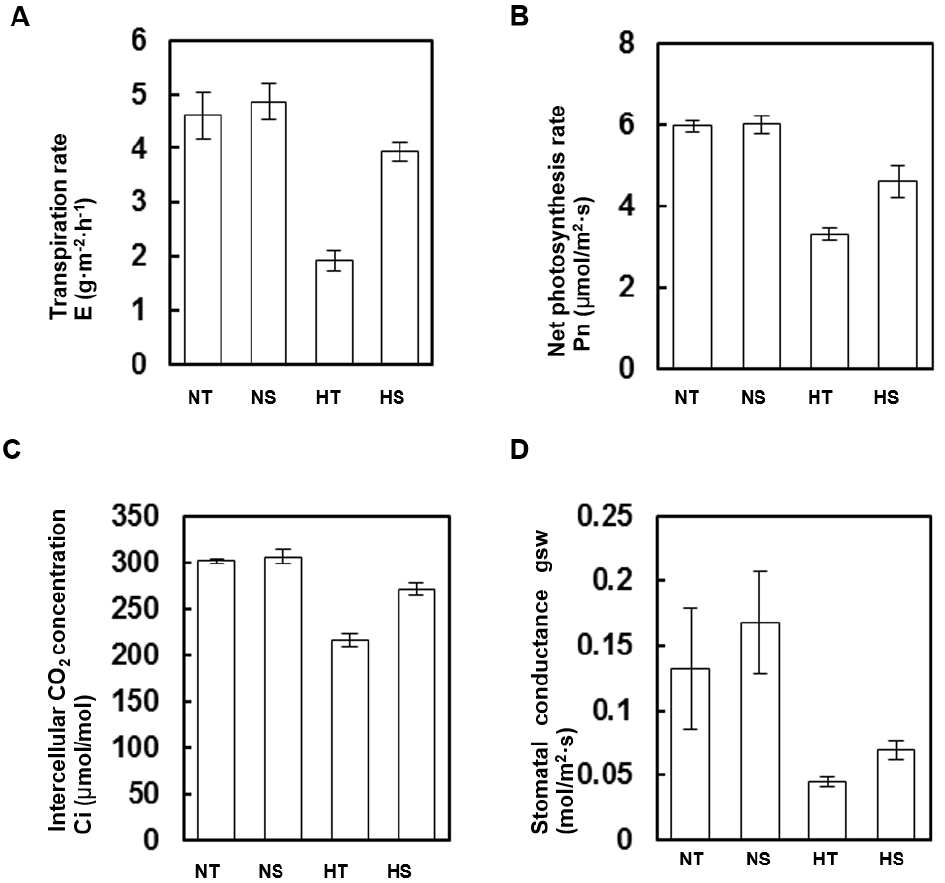
Figure 3. Effects of Spd on gas exchange parameters in tomato leaves under high temperature stress: Transpiration rate ( A ); net photosynthesis rate ( B ); intercellular CO 2 concentration ( C ); and stomatal conductance ( D ). NT, normal growth condition under 25/18 ◦ C and water; NS, normal growth condition under 25/18 ◦ C with 1 mM Spd treatment on plants; HT, high temperature growth condition on 38/28 ◦ C and water treatment; HS, high temperature growth condition on 38/28 ◦ C with 1 mM Spd treatment on leaves.